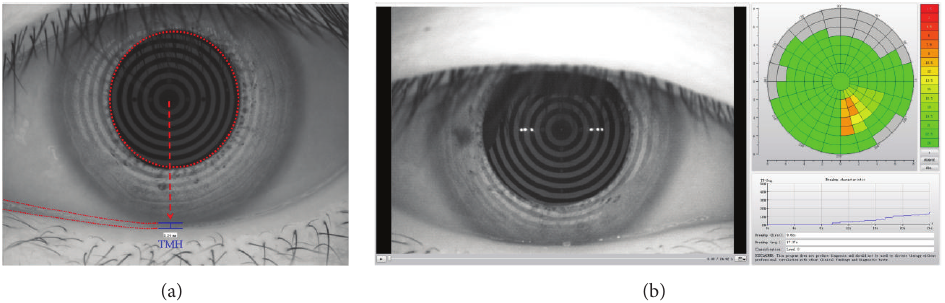
Figure 1: The representative outputs of TMH and NIKBUT. (a) The TMH was measured perpendicular to the lid margin at the central point relative to the pupil center. (b) NIKBUT result map included the color-coded map, breakup characteristics map, and first and average breakup time and